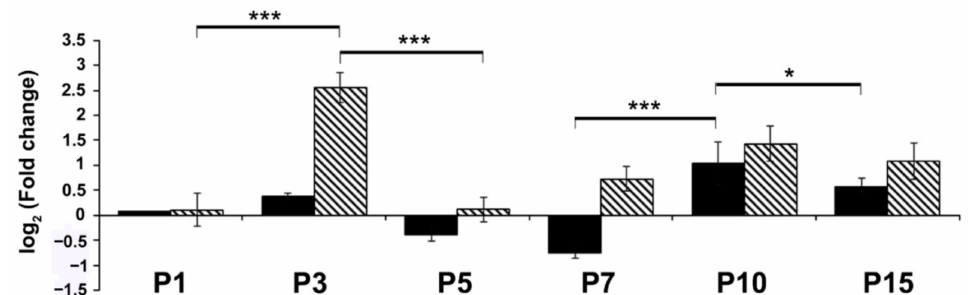
Figure 2. The altered expression of miR-9 revealed by RNA-sequencing (black) and RT-qPCR (striped). The change in miR-9 expression was calculated with U6snRNA as a reference gene for normalization. Fold changes are represented as log2 fold change compared with P21 (* p < 0.05, *** p < 0.001; Table S1).